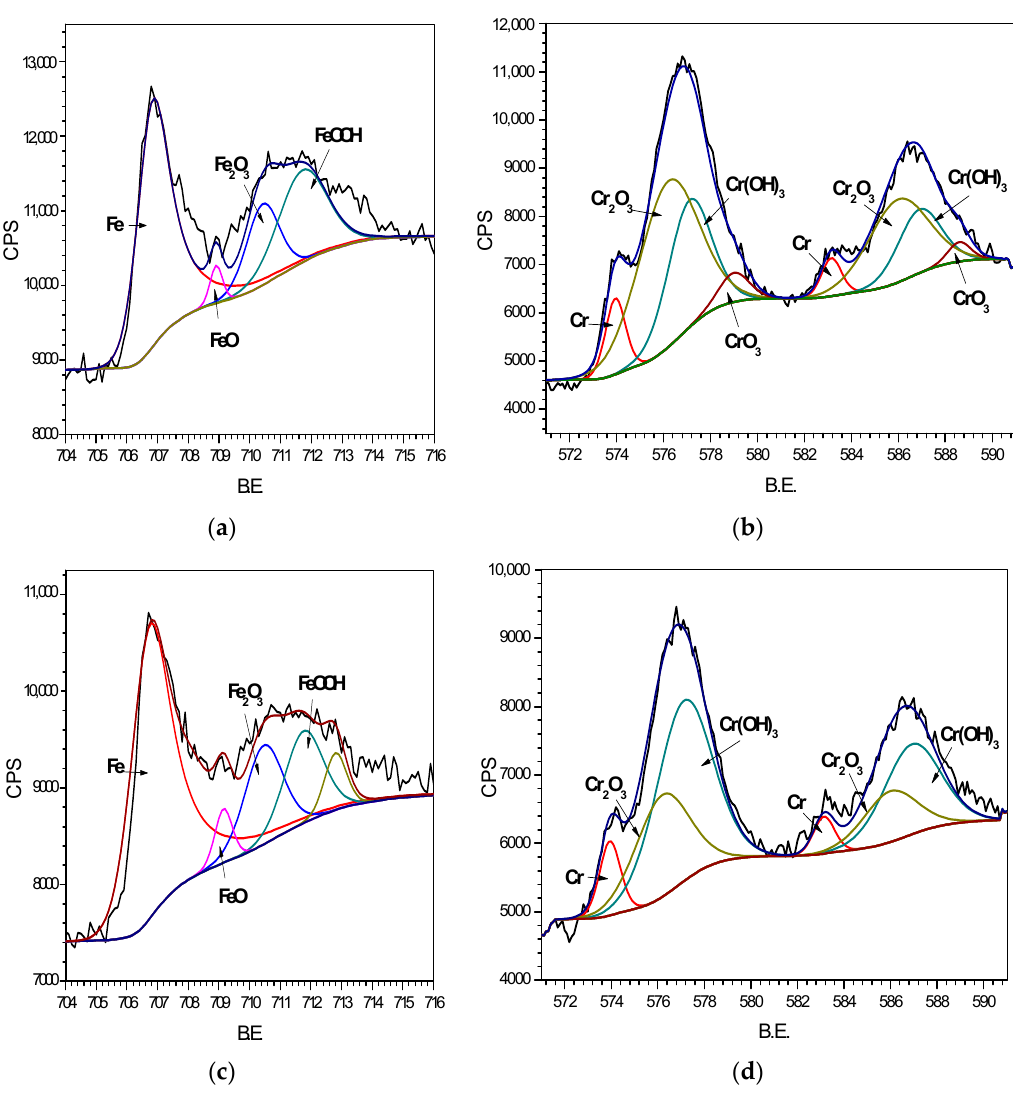
Figure 6. Examples after the 24d exposure of fitted Cr 2p 3/2 and Fe 2p 3/2 . XPS spectra: ( a ) Fe 2p 3/2 spectra of the outer layer; ( b ) Cr 2p 3/2 spectra of the outer layer; ( c ) Fe 2p 3/2 spectra of the inner layer; and ( d ) Cr 2p 3/2 spectra of the inner layer.